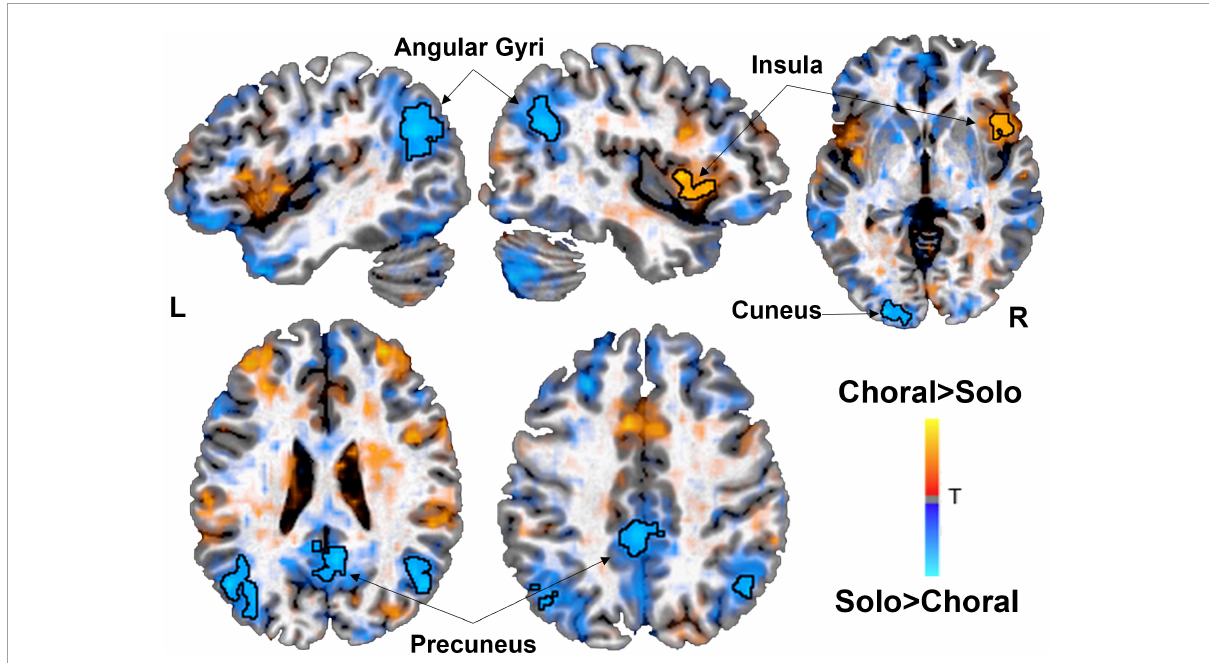
FIGURE2 Brain areas showing significant functional connectivity with the left superior temporal gyrus (STG) seed during choral (warm) vs. solo (cold) reading in adults who stutter (AWS). During choral (fluency induced) reading, the left auditory region showed increased correlated activity patterns with the right insula/inferior frontal gyrus. During solo (stuttering prone) reading, the left auditory region increased functional connectivity with the bilateral angular gyri, cuneus, and precuneus, areas that are part of the default mode network. There were no significant functional connectivity findings in the control group. Statistical map has a threshold at p < 0.05 (corrected).